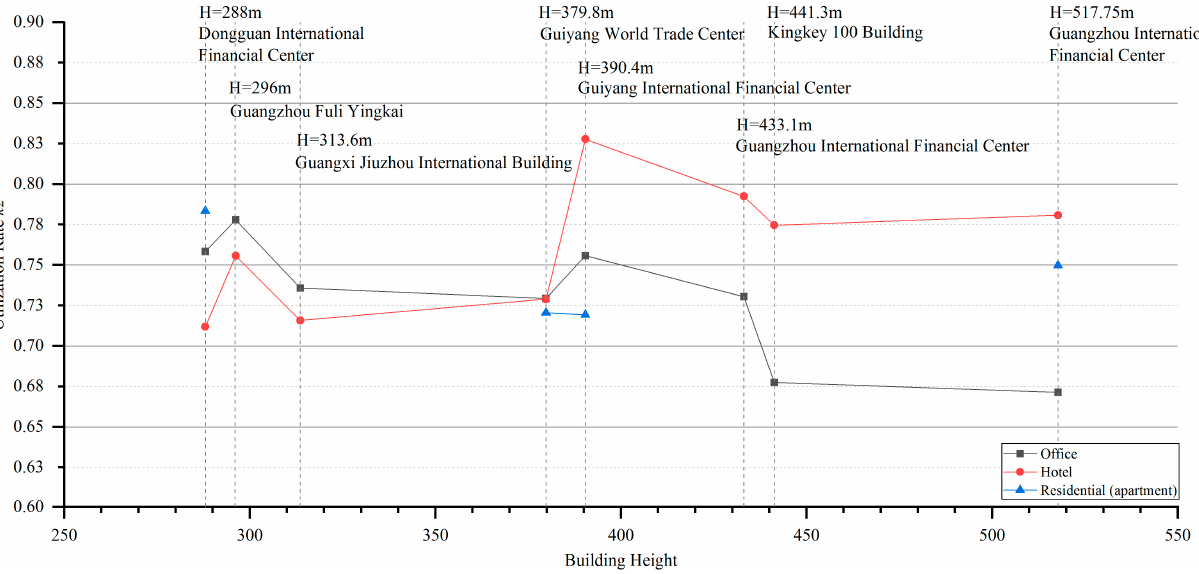
Figure 23. The business utilization rate k 2